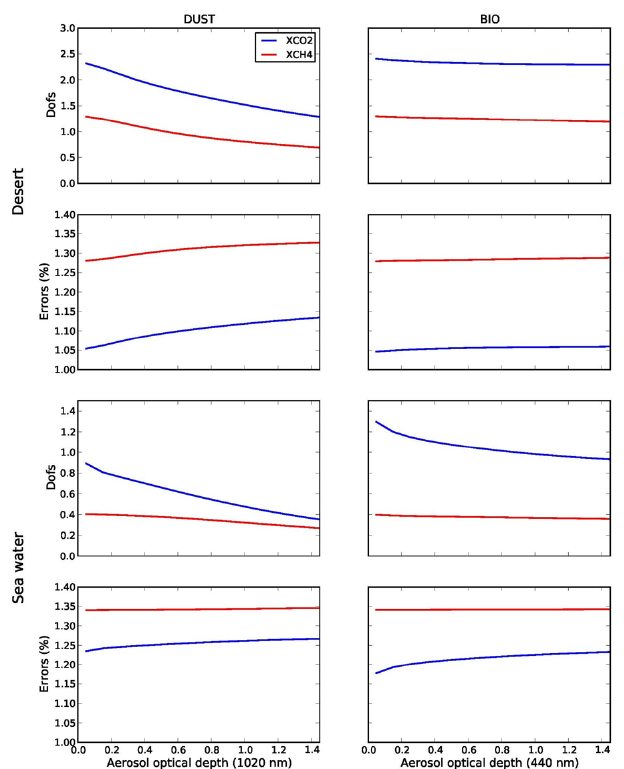
Fig. 6. Gaseous column DOFSs and errors (in %) vs. AOD for chan- nel selection. CO 2 is in blue lines and CH 4 is in red lines.